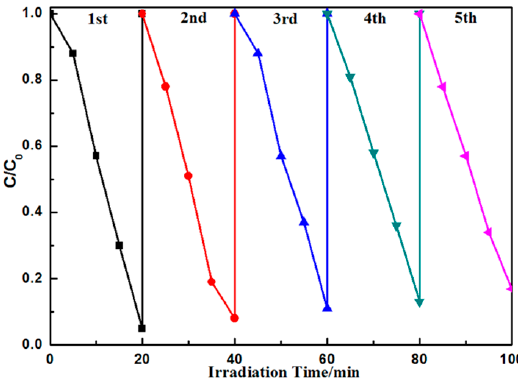
Figure 10. Cycling runs for the photocatalytic degradation of MB in the presence of Ag@AgBr(7 wt %)/Bi 2 O 2 CO 3 under visible light irradiation.